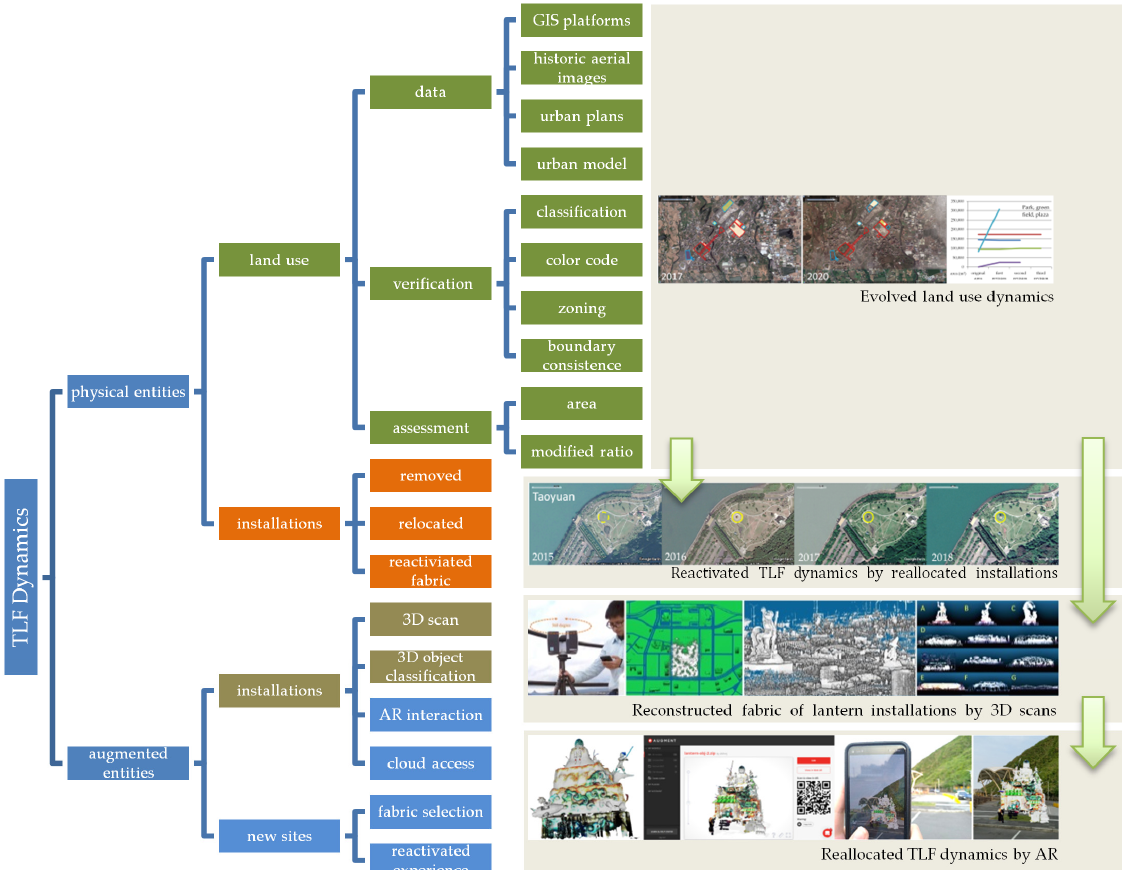
Figure 2. Research framework and flowchart.